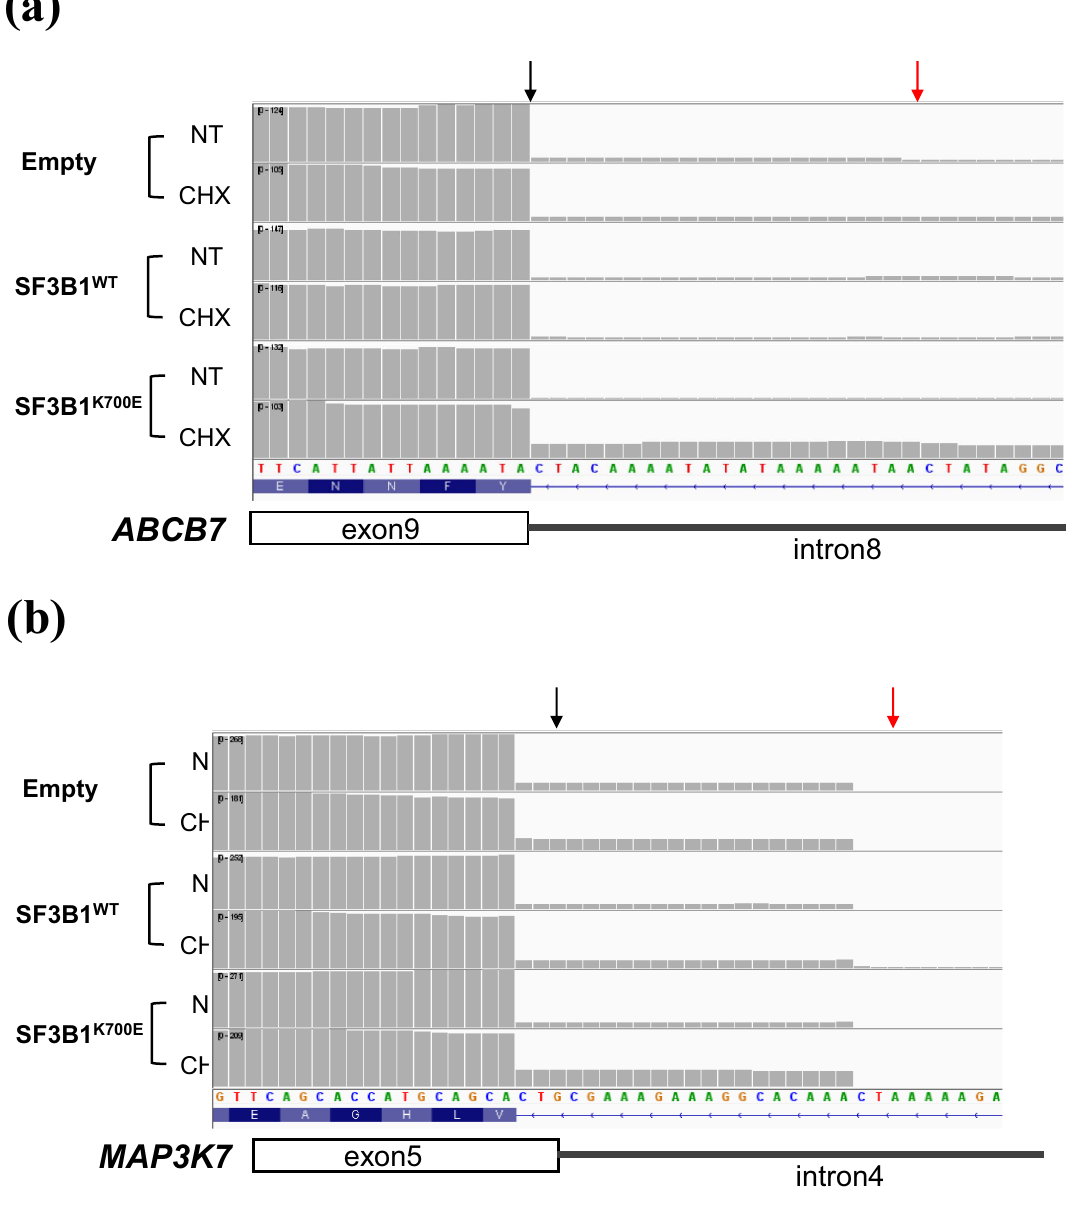
Figure 3. Detection of A3SS events in ABCB7 and MAP3K7 with HUDEP-2 cells stably expressing SF3B1 K700E with or without CHX treatment. (a-b) Read-coverage visualized by IGV around canonical 3 ′ SS of ABCB7 exon 9 ( a ) and canonical 3 ′ SS of MAP3K7 exon 5 ( b) . Black and red arrow indicate canonical and aberrant 3 ′ SS, respectively. Empty, SF3B1 WT and SF3B1 K700E indicate HUDEP-2 cells transduced with control vector, HUDEP-2 cells stably expressing SF3B1 WT and HUDEP-2 cells stably expressing SF3B1 K700E , respectively. NT and CHX indicate the non-treated samples and the samples treated with CHX,